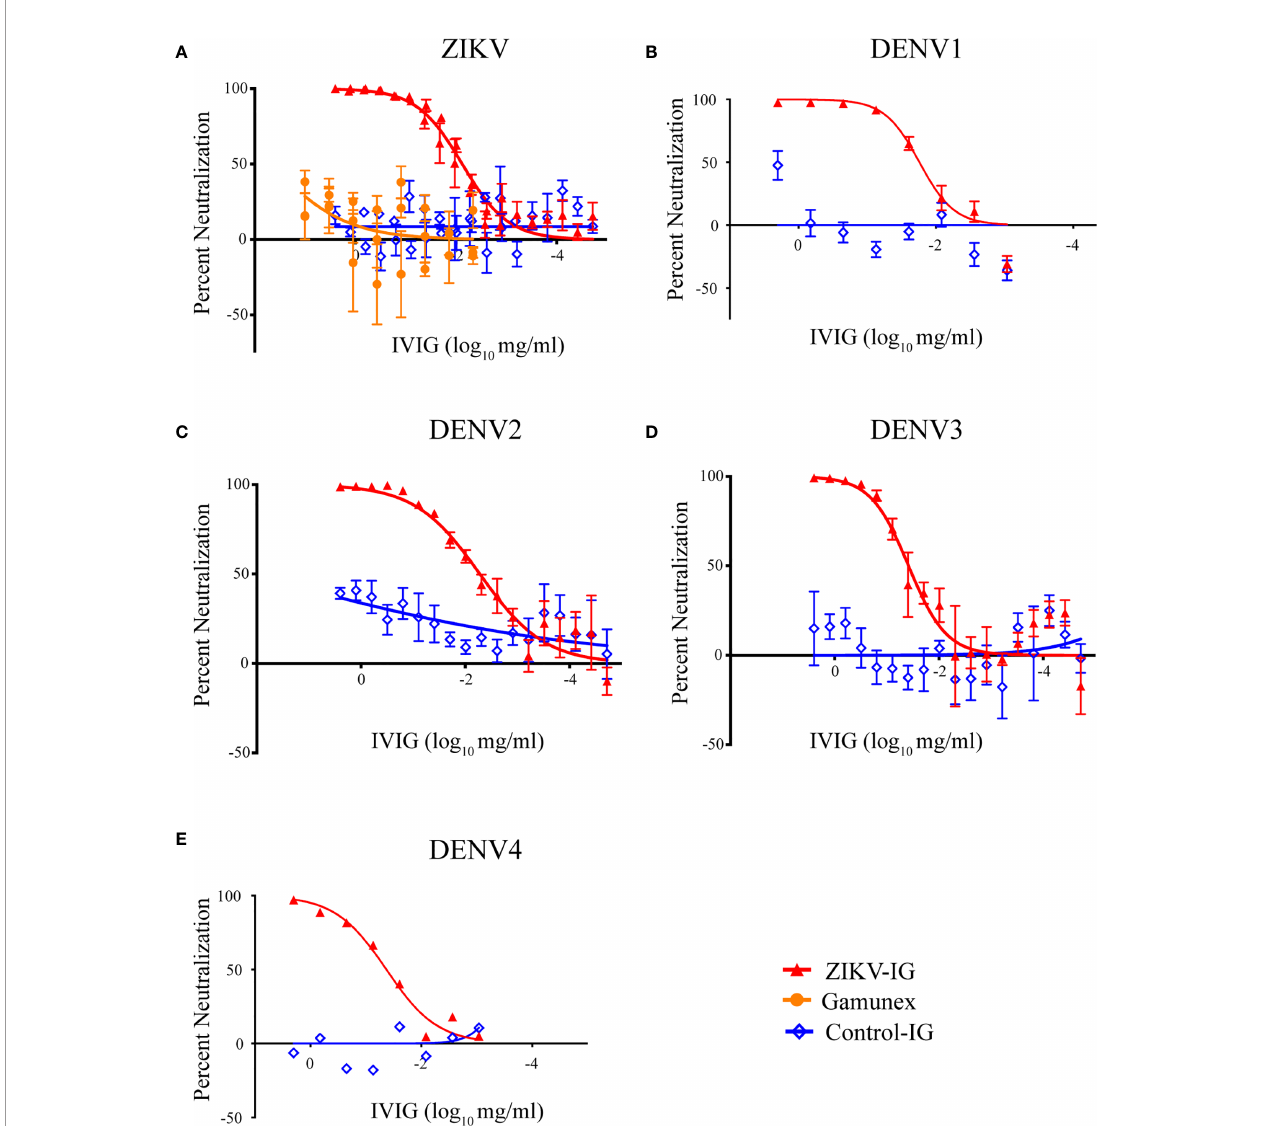
FIGURE 1 | Human IVIG can neutralize ZIKV and DENV1-4. The ability of IVIG products, ZIKV-IG, Control-Ig, and Gamunex ® to neutralize (A) Zika virus strain PRVABC59, (B) DENV1, (C) DENV2, (D) DENV3 and (E) DENV4 were completed by focus reduction neutralization test using Vero cells. Serial dilutions of serum were incubated with a constant amount of virus and individual foci were counted. Foci counts are normalized to the number of foci in PBS control wells. Data shown as single points that represent the mean of 3-4 independent experiments completed in duplicate +/- SEM. Solid lines display the nonlinear regression log vs. response with variable slope.